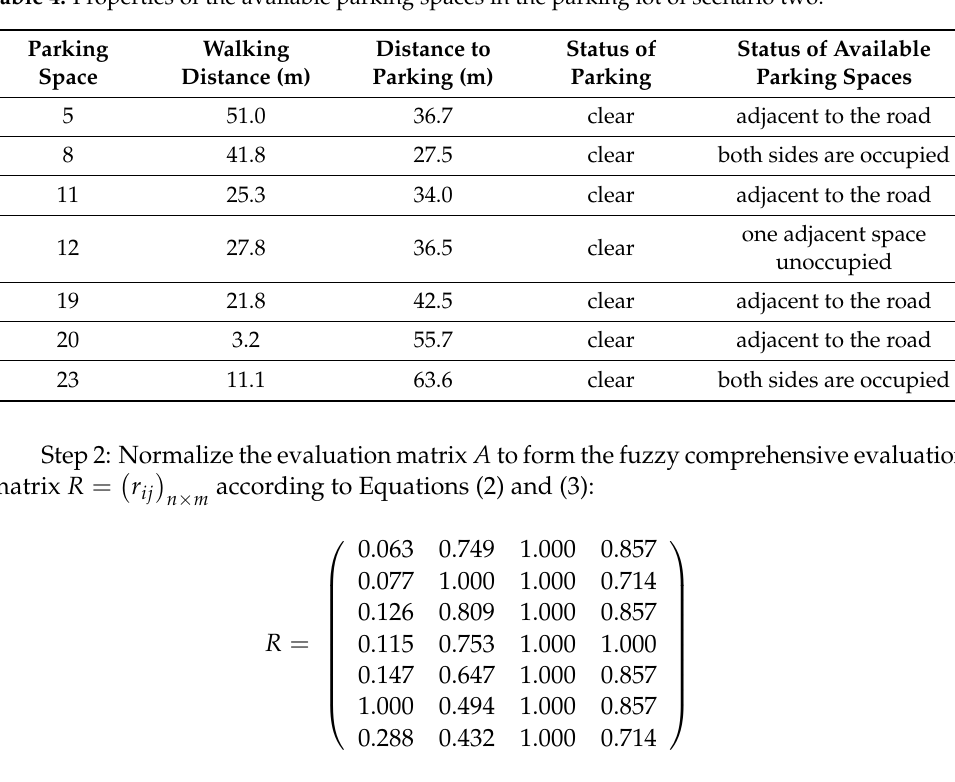
Figure 8. Example of a parking scenario three. Table 4. Properties of the available parking spaces in the parking lot of scenario two.